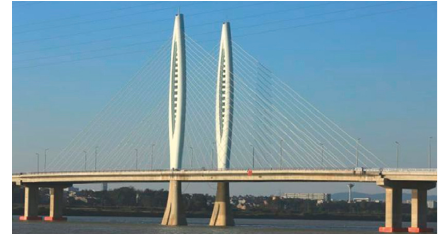
Figure 1: Jishui Gan River Second